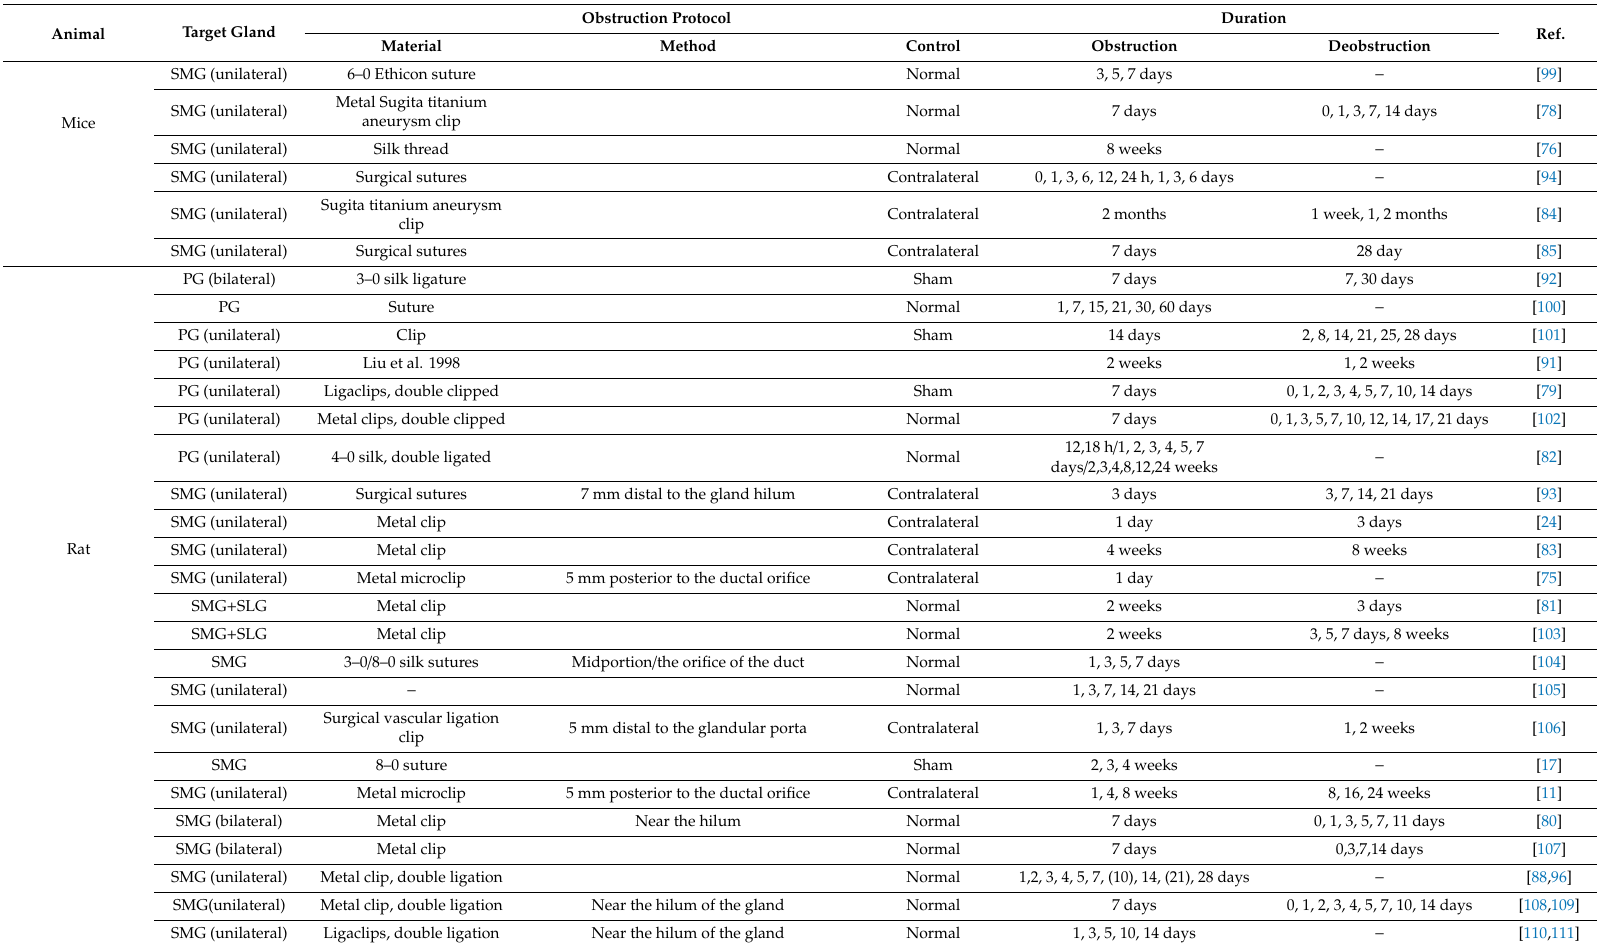
Table 3. Obstruction protocols in previous